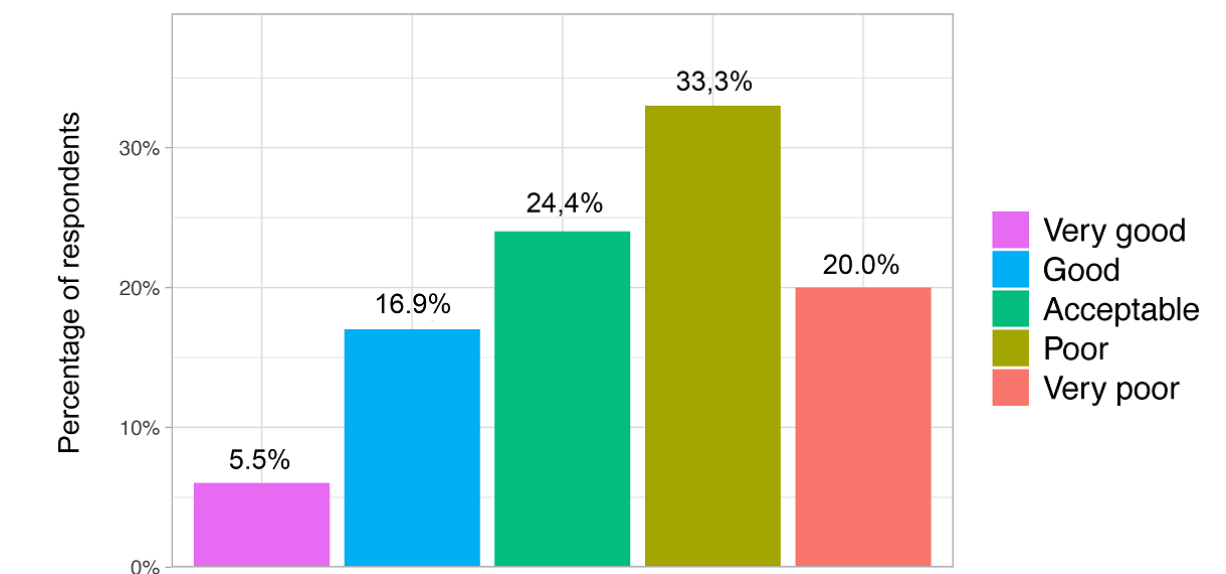
Figure 1. Self-evaluation in response to the statement: "I evaluate my eHealth skills (eg, working with clinical decision support systems, remote patient monitoring systems, artificial intelligence, applications in radiology)